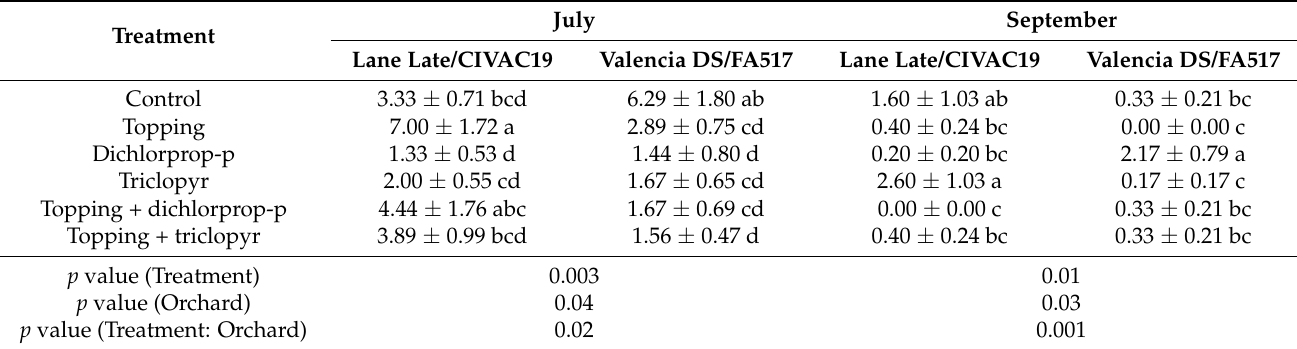
Table 2. Shoot number ± standard error (SE) under the effect of six different treatments (control, topping, dichlorprop-p, triclopyr, topping + dichlorprop-p and topping + triclopyr) in the two experimental orchards with different rootstocks (CIVAC19 and Forner-Alcaide no. 517) and cultivars (‘Lane Late’ and ‘Valencia Delta Seedless’) for the evaluations of 2019.